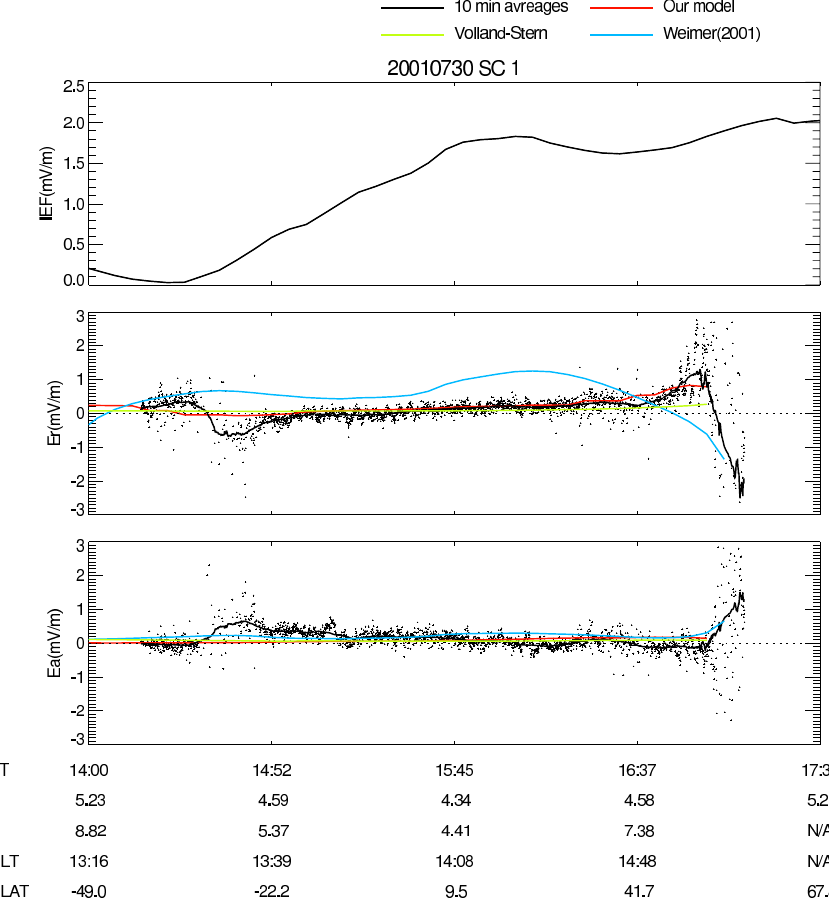
Fig. 7. Comparison between electric fields from original Cluster (SC 1) measurement, its running average, our model, Volland-Stern model, and Weimer (2001) model for 30 July 2001. The panels show the IEF, an input parameter for our model, and radial and azimuthal electric fields. The UT, radial distance ( R ), L-value, MLT, and magnetic latitude (MLAT) are shown in the bottom. If the L-value and MLT are not available through mapping by the Tsyganenko model, they are indicated as